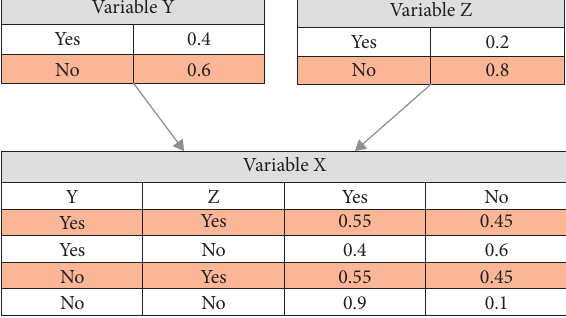
Figure 3: Sample